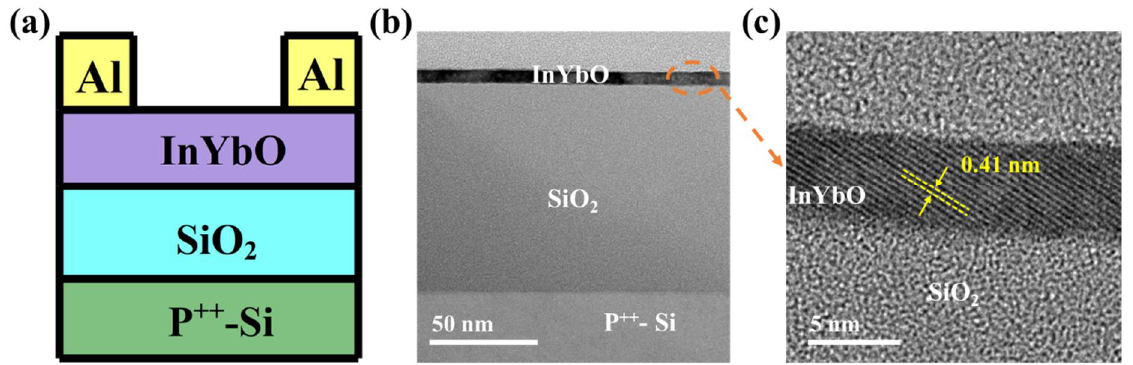
Figure 6. ( a ) Schematic architecture, ( b ) cross-sectional TEM image of the In-Yb-O (10% Yb) device, and ( c ) HRTEM image of selected area marked with a red circle in panel b.